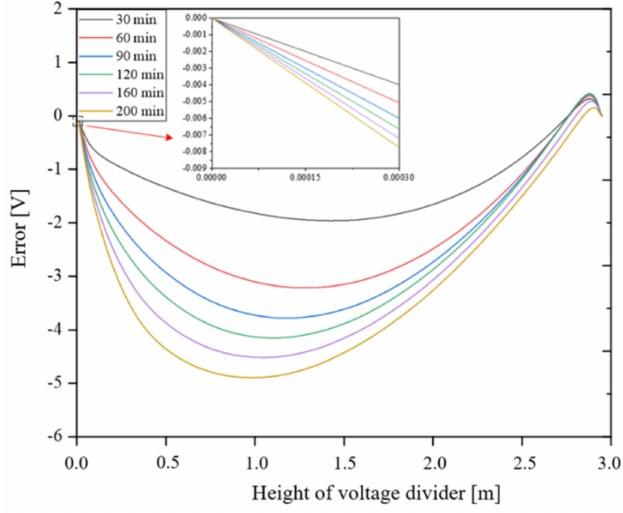
Figure 8. Voltage divider simulation error with transient temperature